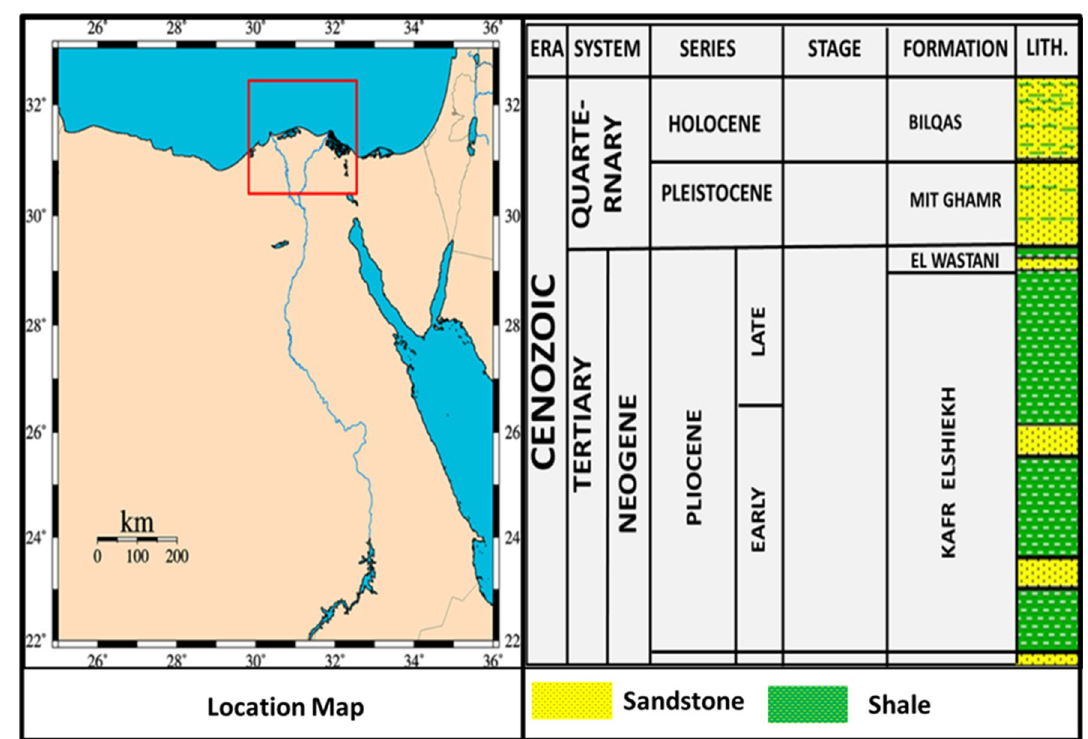
Fig. 1 Area under study, showing a generalized stratigraphic